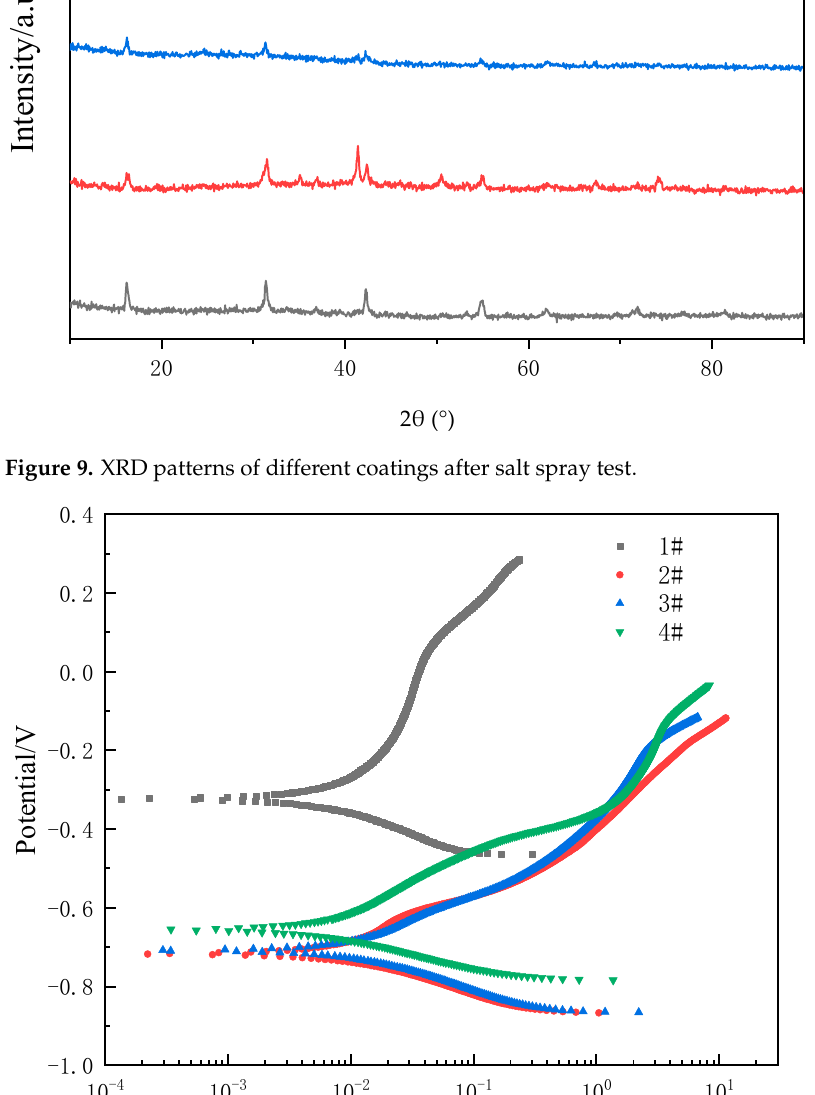
Figure 10. Potentiodynamic polarization curve of CS FAA coating and laser re-melting FAA CS coating in seawater after 96 h immersion.